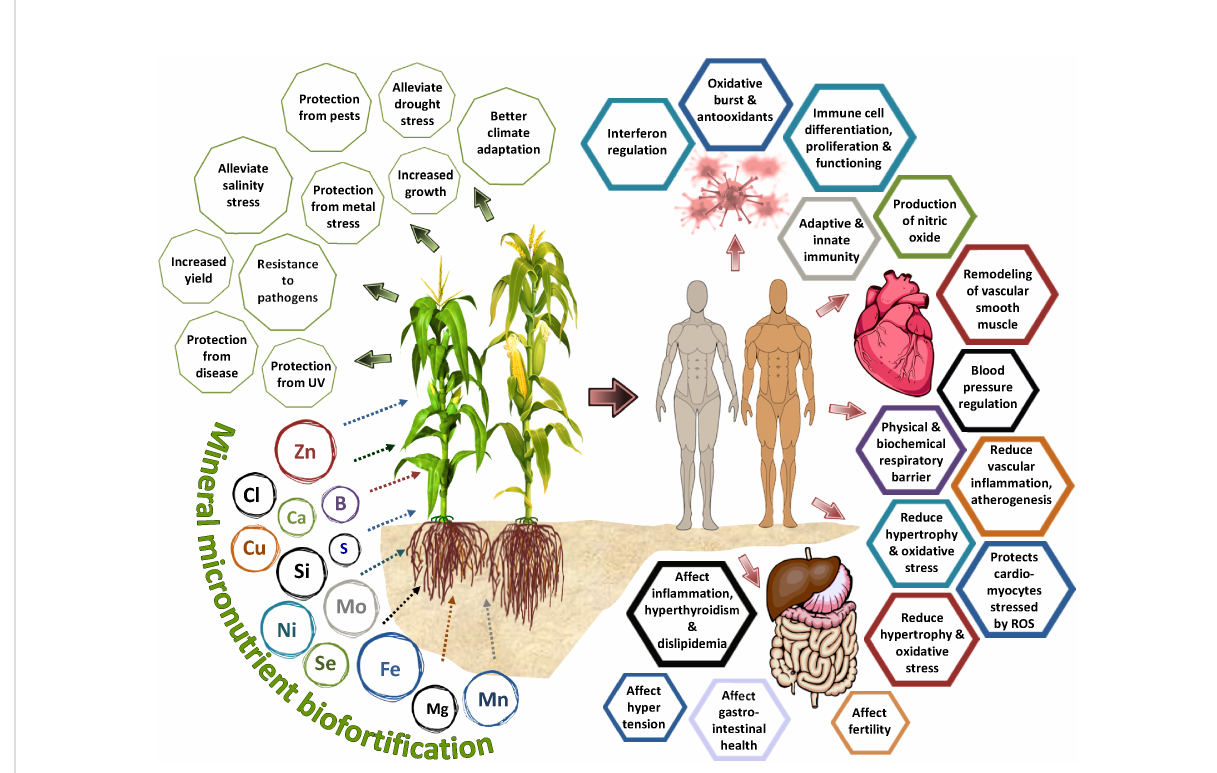
FIGURE 1 In fl uence of mineral micronutrient bioforti fi cation on the plant physiological processes and its relation to human health and